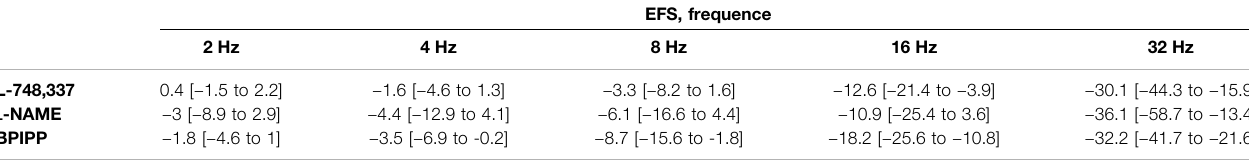
TABLE 4 | Mean differences (MD) for EFS-induced contractions of human prostate tissues after application of either L-748,337, L -NAME, or BPIPP both to control and mirabegron groups, followed by application of mirabegron (10 µM) or DMSO for controls, shown for each applied frequency and with 95% con fi dence intervals (CI) (in square brackets, low to high) (% of KCl-induced contractions). Differences in contraction at given frequencies were calculated for each single experiment (i. e., between mirabegron and control group, for corresponding, paired samples from the same prostate in each single experiment), and are expressed as MD with 95% CI.